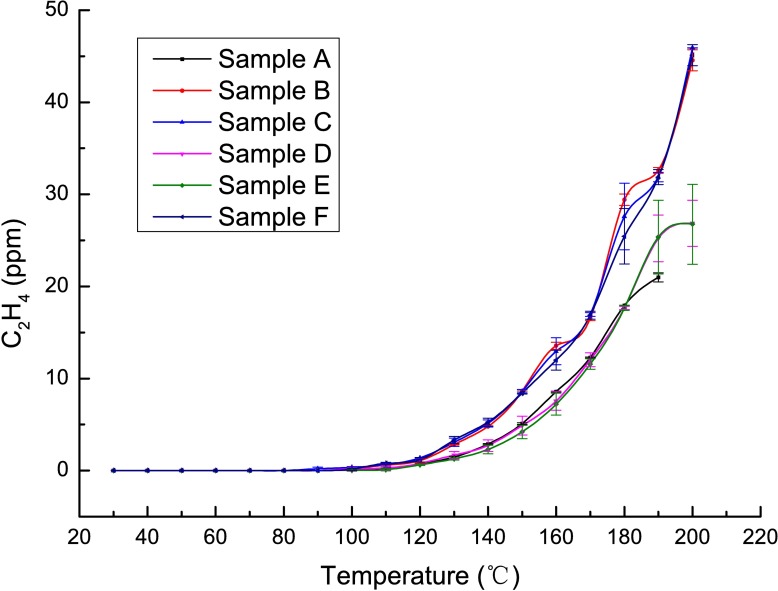
Temperature-dependent variations in C2H4 contents.